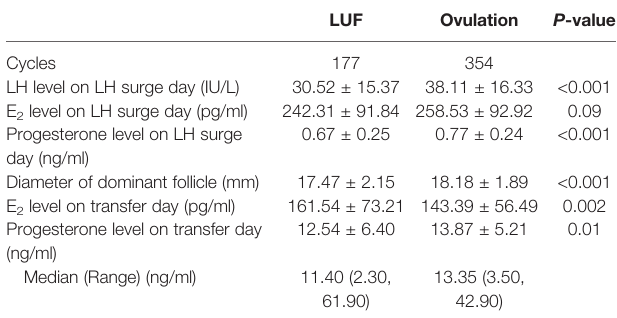
TABLE 3 | Serum levels of sex hormones on LH surge day and embryo transfer day. However, early pregnancy loss rate in the LUF group was lower than that in the ovulation group, but the difference was only LUF Ovulation P -value marginal ( P = 0.06). Although there was a lower live birth rate in the LUF group (43.50 vs. 50.00%), no signi fi cant difference was found between the two groups ( P = 0.16). After adjusting for the luteal support protocols, clinical pregnancy rate was still signi fi cantly lower in the LUF group (adjusted P = 0.01, OR